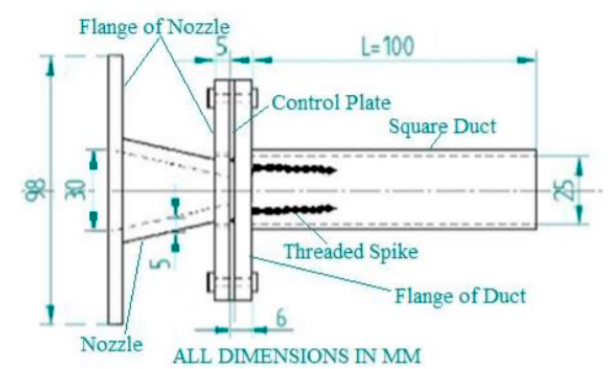
Figure 13. Square nozzle with threaded spikes control plate [23].